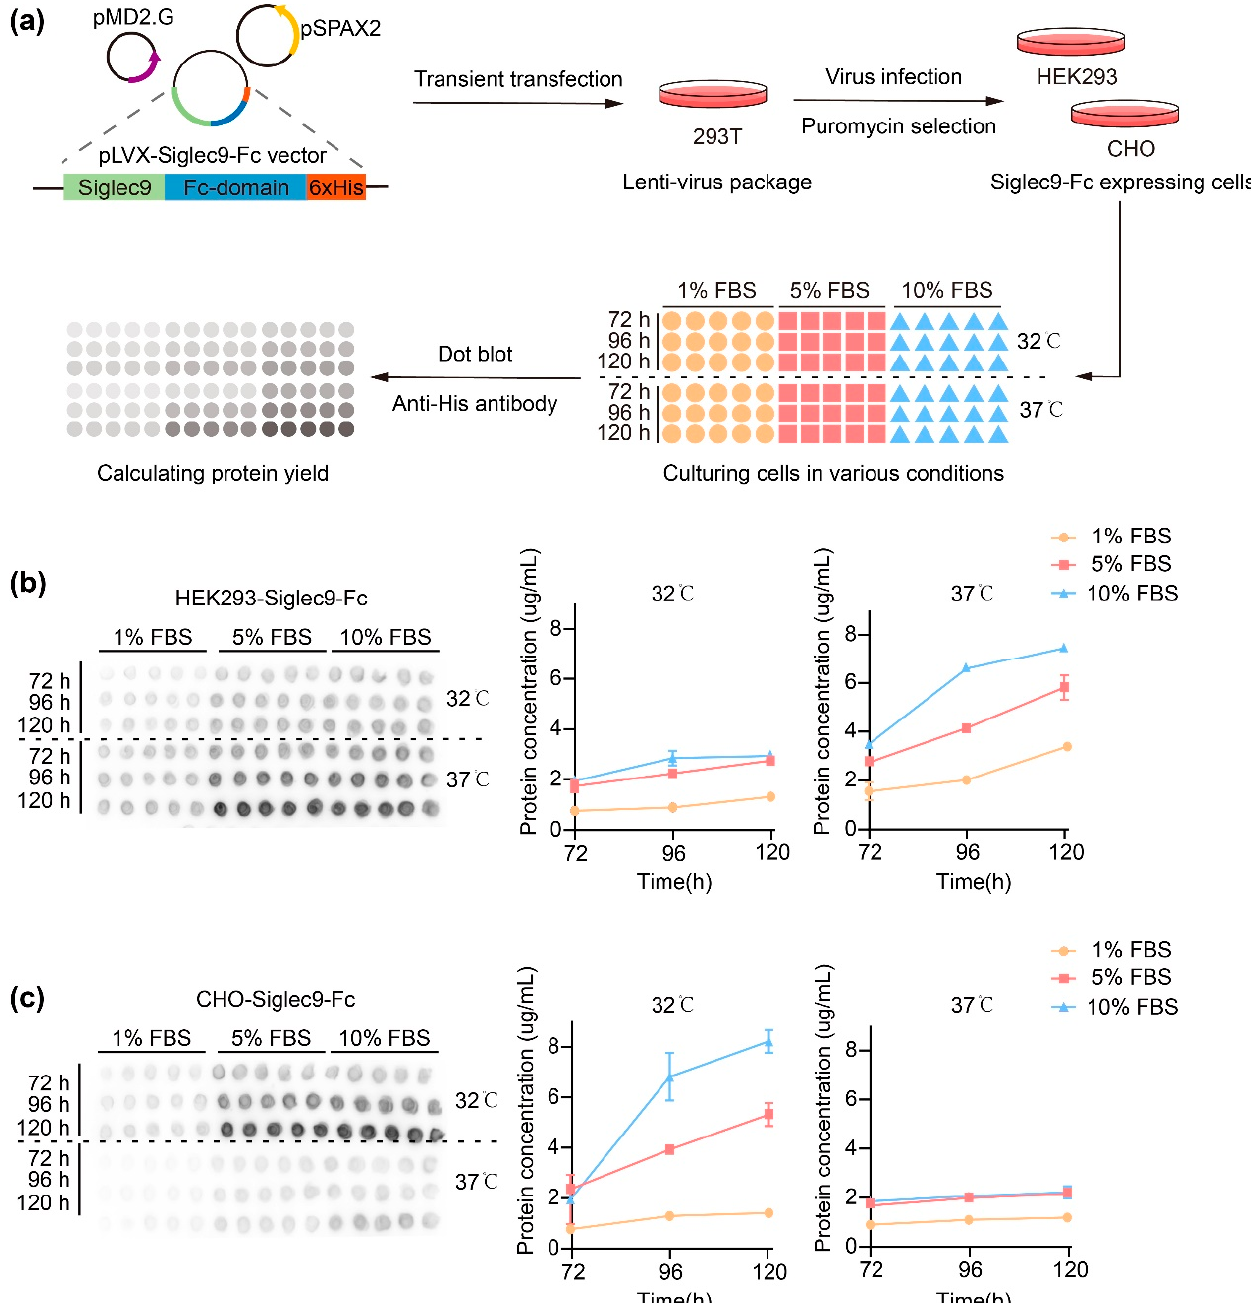
Figure 1. Optimizing culture conditions in mammalian cells. ( a ) Workflow of Siglec9-Fc expressing cell construction and culture condition optimization; ( b ) The results of dot blot and protein yield quantification in HEK293 cells, detected by anti-His antibody; ( c ) The results of dot blot and protein yield quantification in CHO cells, detected by anti-His antibody.